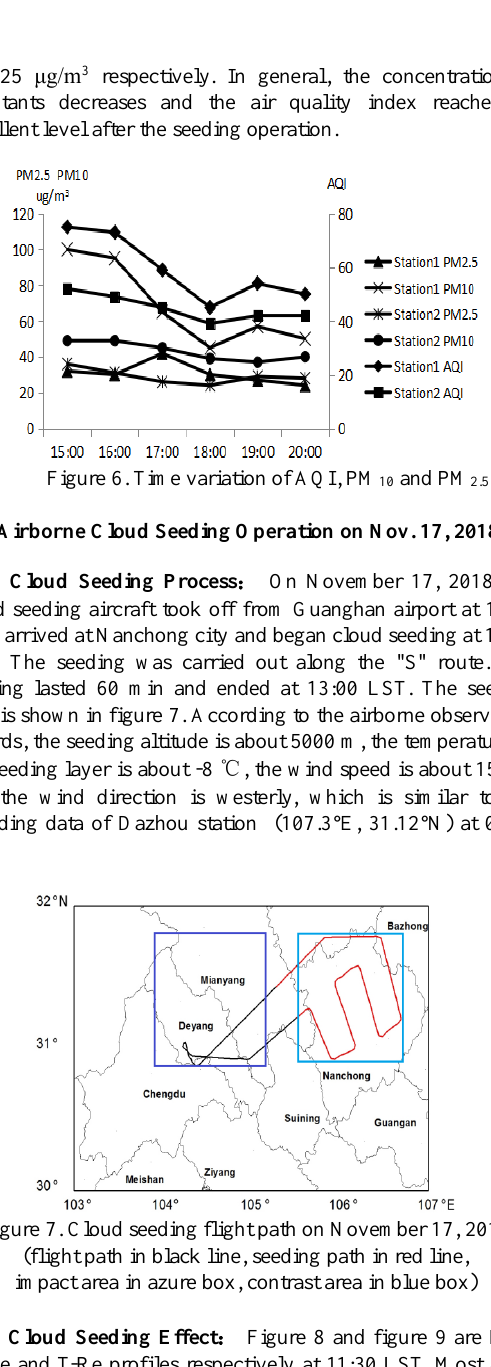
Figure 9. T-Re profiles at 11:30 LST (a: region 1; b: region 2; c: region 3) Figure 10 and figure 11 are respectively the RGB image and T- Re profiles at 12:30 LST. At this time, the seeding operation is under way. As can be seen from the figure, the seeding region is mainly pink and yellow cloud. Considering the wind speed and direction, this cloud area is thought to have moved here from the yellow and light red cloud area at 11:30 LST. The cloud top temperature in the seeding region is between -9 ℃ and -12 ℃ , and the effective radius of the cloud droplets is between 8 micron and 11 micron. Compared with 11:30 LST,